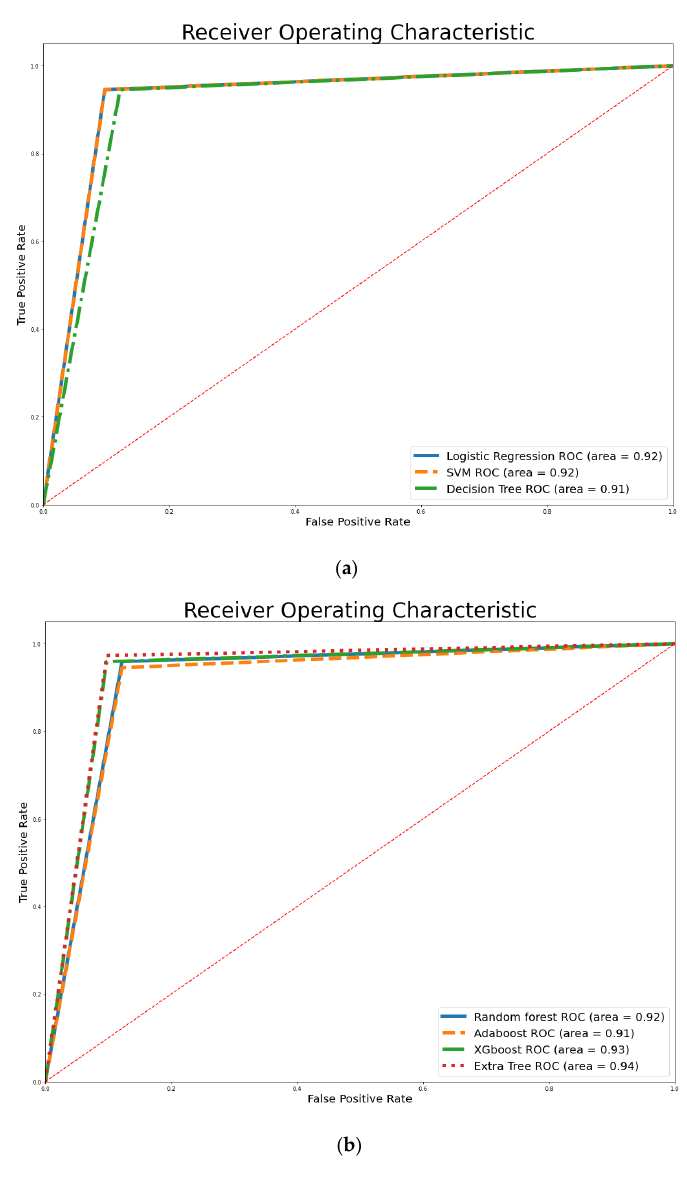
Figure 4. AUC values: ( a ) weak classifiers, ( b ) ensemble classifiers. (The red diagonal shows the AUC of 0.5m which separates the line to above or under 50%)